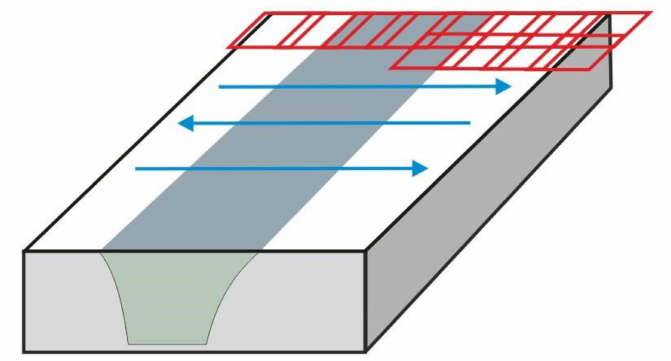
Figure 3. Methodology of taking a series of 64 photos by a light microscopy to create the macro- structure of the weld